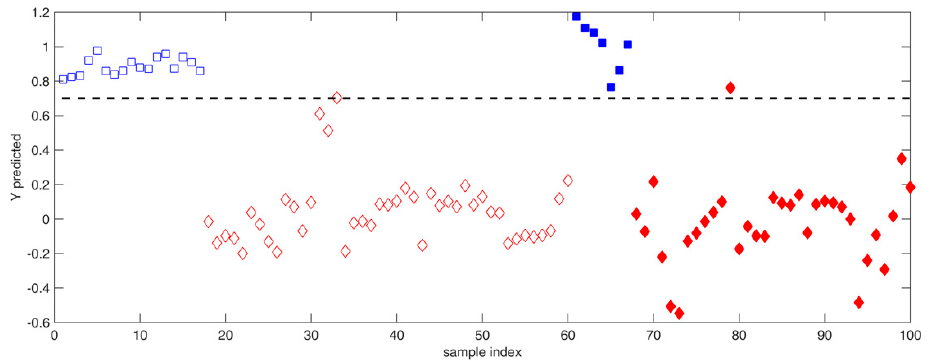
Figure 2. PLS-DA analysis: predicted Y vs sample index. Legend: “Class Conformant: Blue Squares; “Class Adulterated”: Red diamonds. Empty and filled symbols represent training and test samples, respectively.